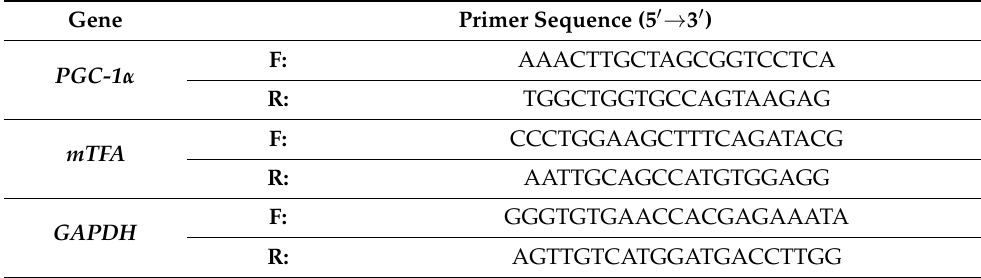
Table 2. Sequences of